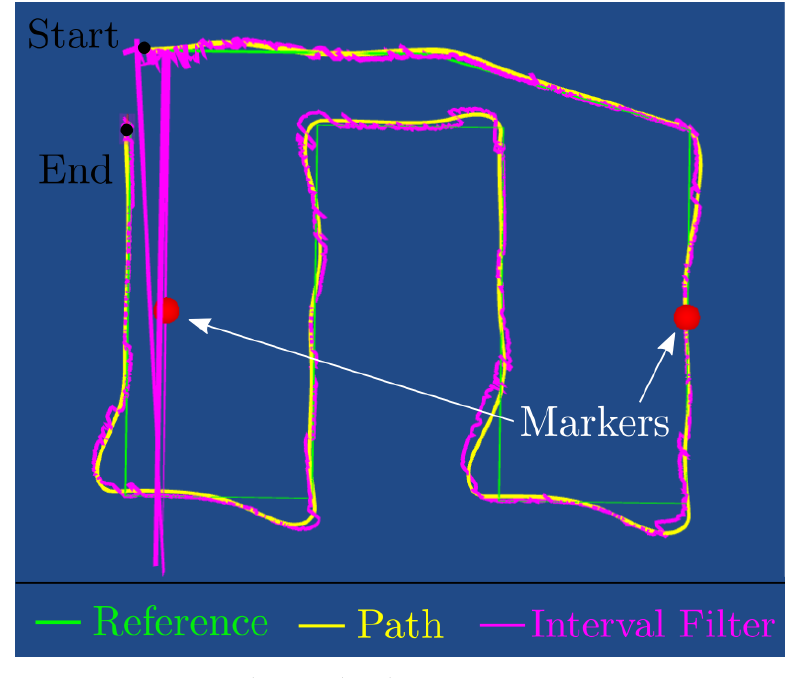
Figure 4. Scenario 1 with interval analysis.